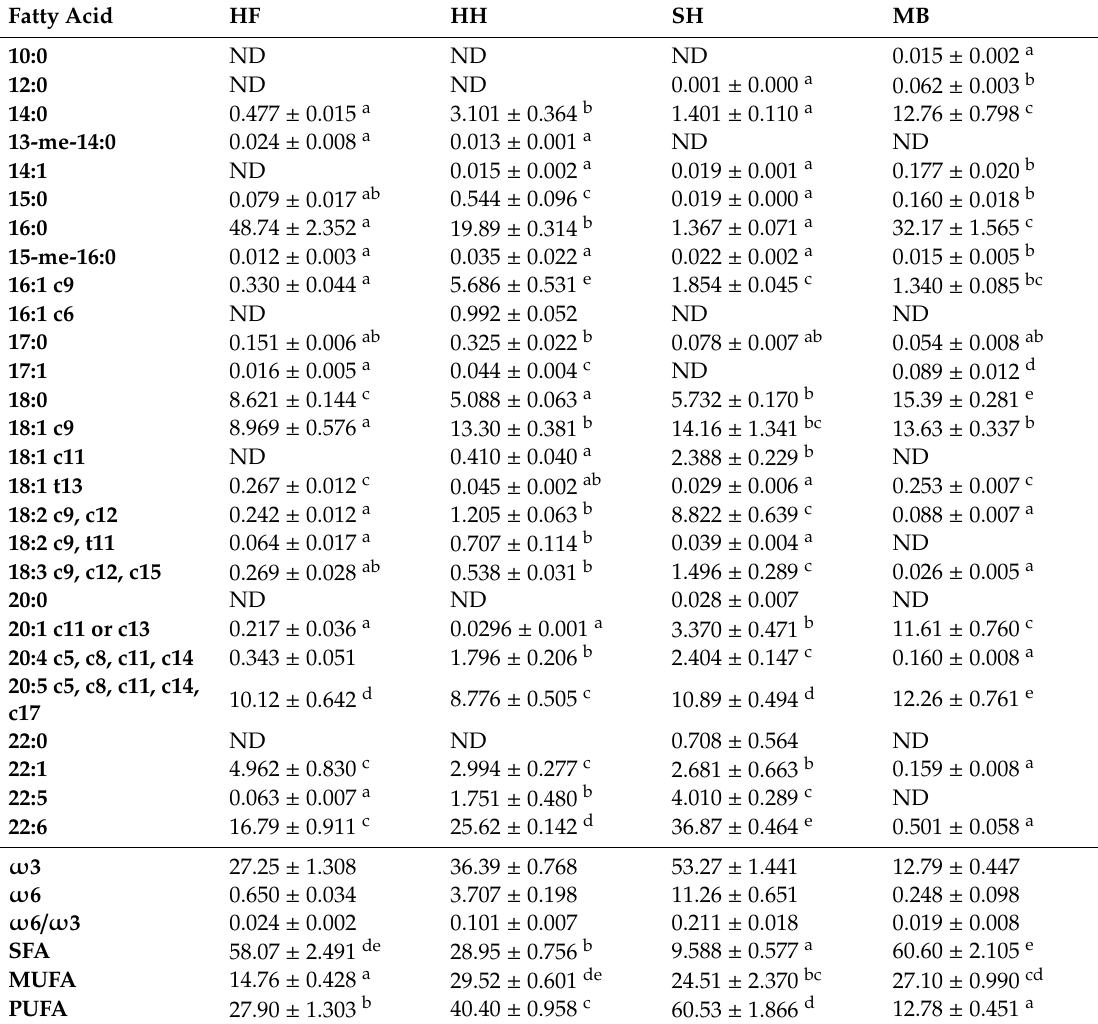
Table 2. The fatty acid profile of the polar lipid extracts of herring fillets and heads, salmon heads and minced boarfish expressed as a percentage of the total fatty acids of each sample (mean ± SD, n =